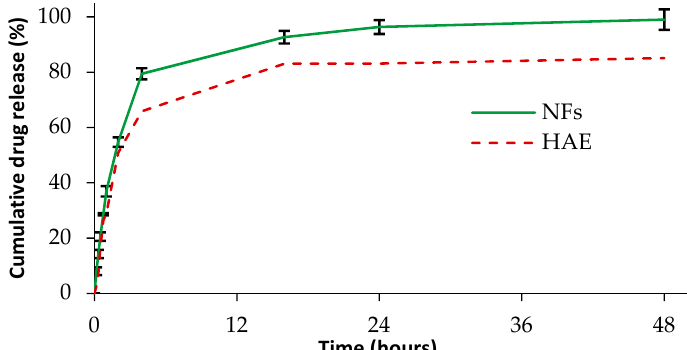
Figure 7. The in vitro dissolution profiles of HAE (as a powder form; a dotted red curve) and HAE-loaded amphiphilic electrospun NFs (a continuous green curve) ( n = 3).